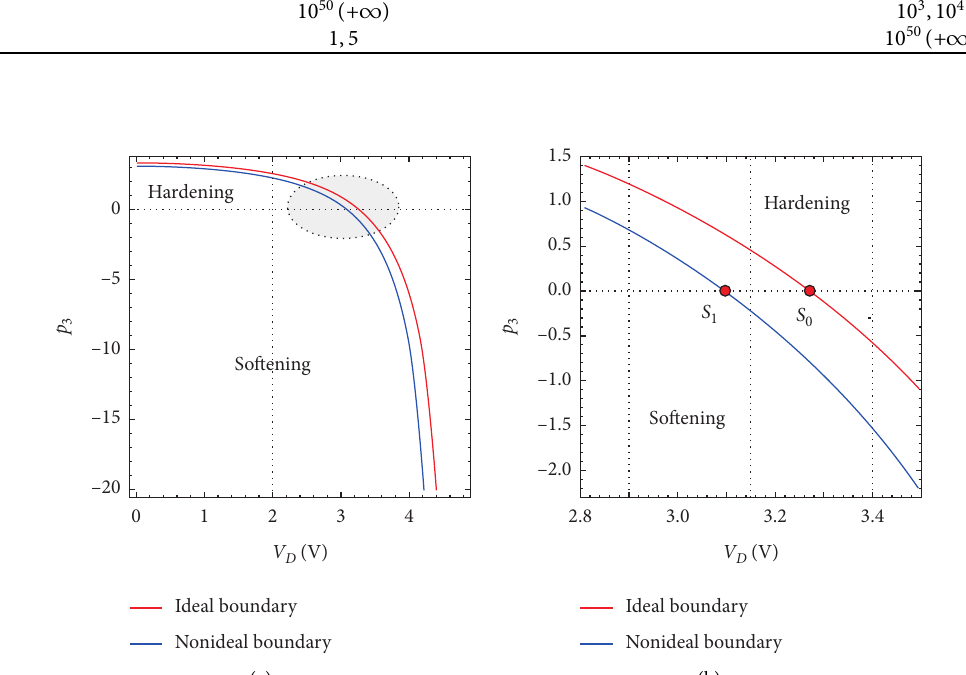
Figure 8: Key parameters of local soft and hard characteristics. (a) Relationship between parameter p boundary conditions. (b) Partial enlarged detail.